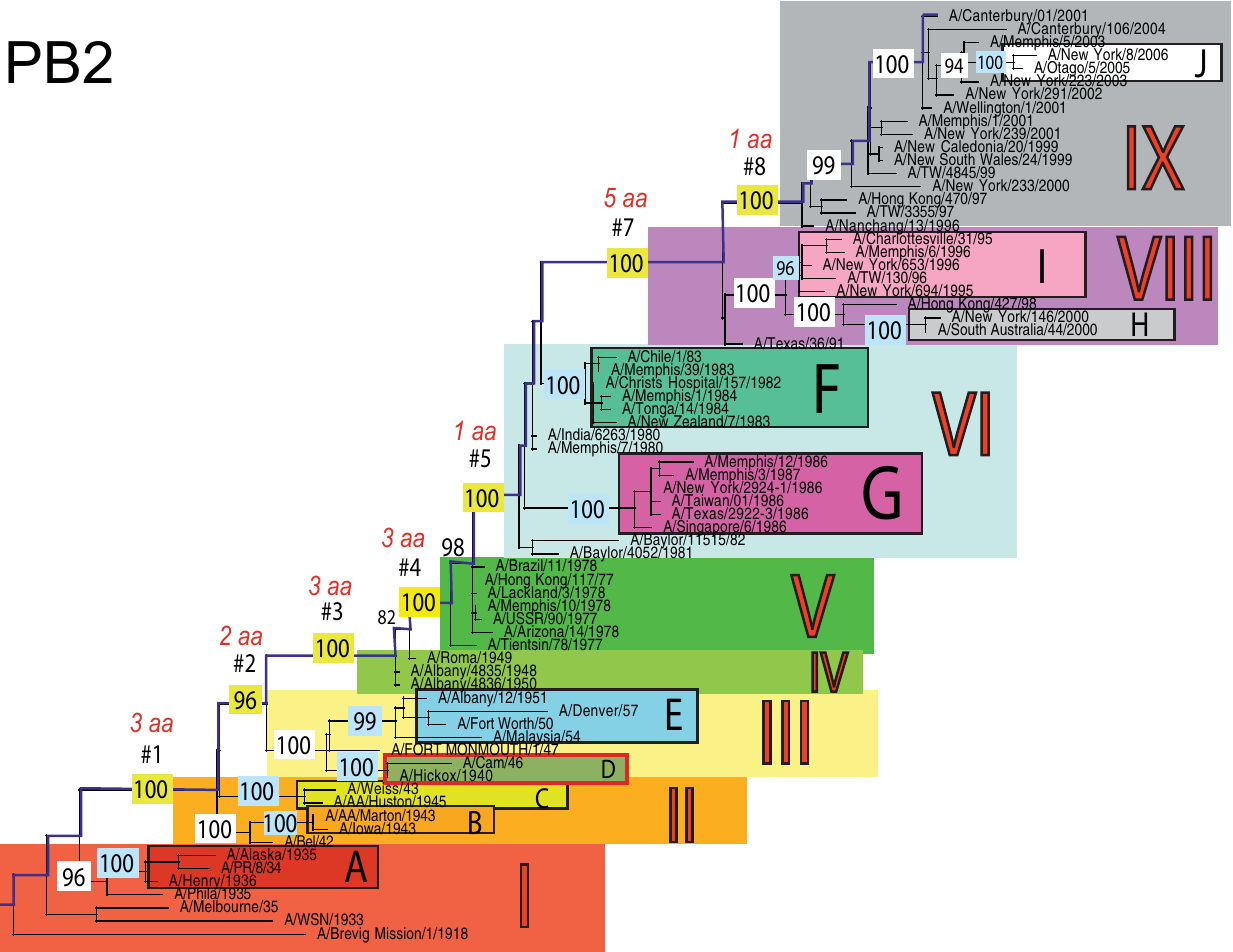
Figure 1. Phylogenetic relationships of the PB2 gene of A/H1N1 influenza viruses (n=71) sampled globally from 1918–2006, estimated using a maximal likelihood (ML) method. All branch lengths are drawn to a scale of nucleotide substitutions per site. The tree is rooted using the oldest sequence, A/Brevig Mission/1/1918, and temporally ordered with the oldest isolates falling at the bottom left of the phylogeny and the newest isolates at the top right. Main phylogenetic sections that are separated by long trunk branches are numbered I–IX and colored as follows: section I is red, section II is orange, section III is yellow, section IV is light green, section V is dark green, section VI is light blue, section VII is absent due to the position of clade G within section VI (would otherwise be blue), section VIII is purple, and section IX is gray. The trunk branches separating these sections are labeled # 1– # 8 and highlighted in dark blue, with the bootstrap value supporting this branch highlighted in yellow and the number of amino acid changes that occur along each branch appearing above in red font. Ten main clades are labeled A–J, with supporting bootstrap values in light blue, and are colored as follows: clade A is dark red, clade B is orange, clade C is yellow, clade D is olive green, clade E is light blue, clade F is turquoise, clade G is fuchsia, clade H is gray, clade I is pink, and clade J is white. Clades that have undergone reassortment are outlined in red (in this case Clade D).